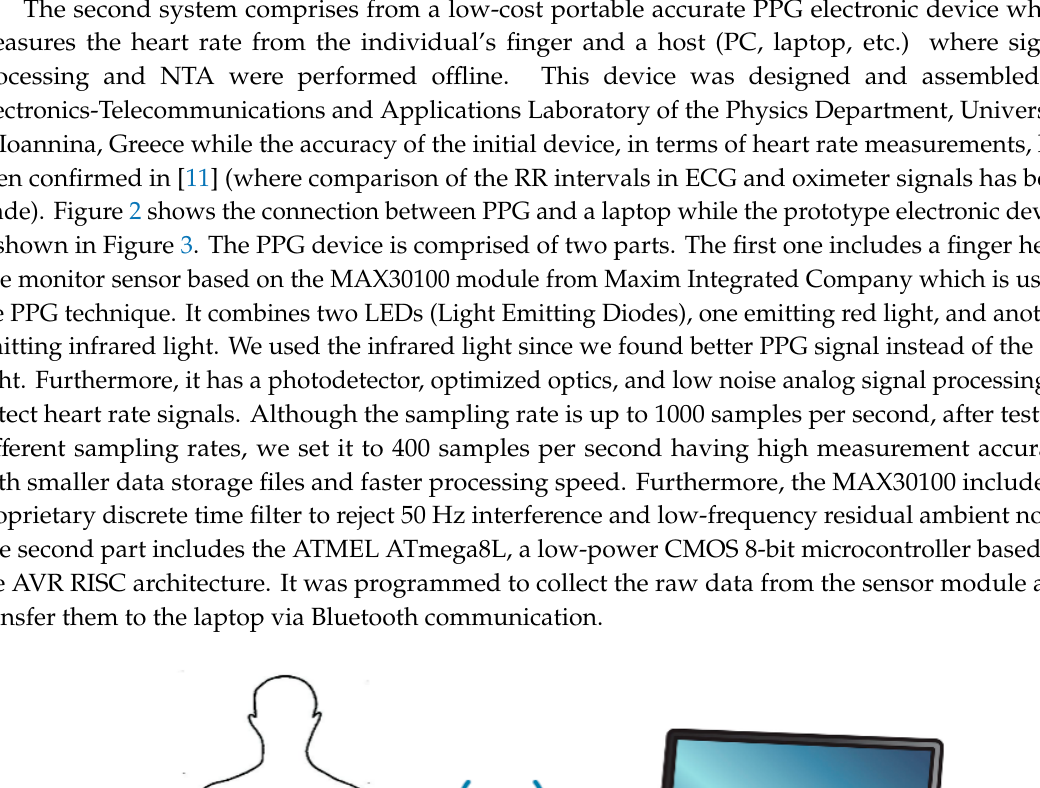
Figure 2. Connectivity of the prototype photoplethysmography (PPG) system.